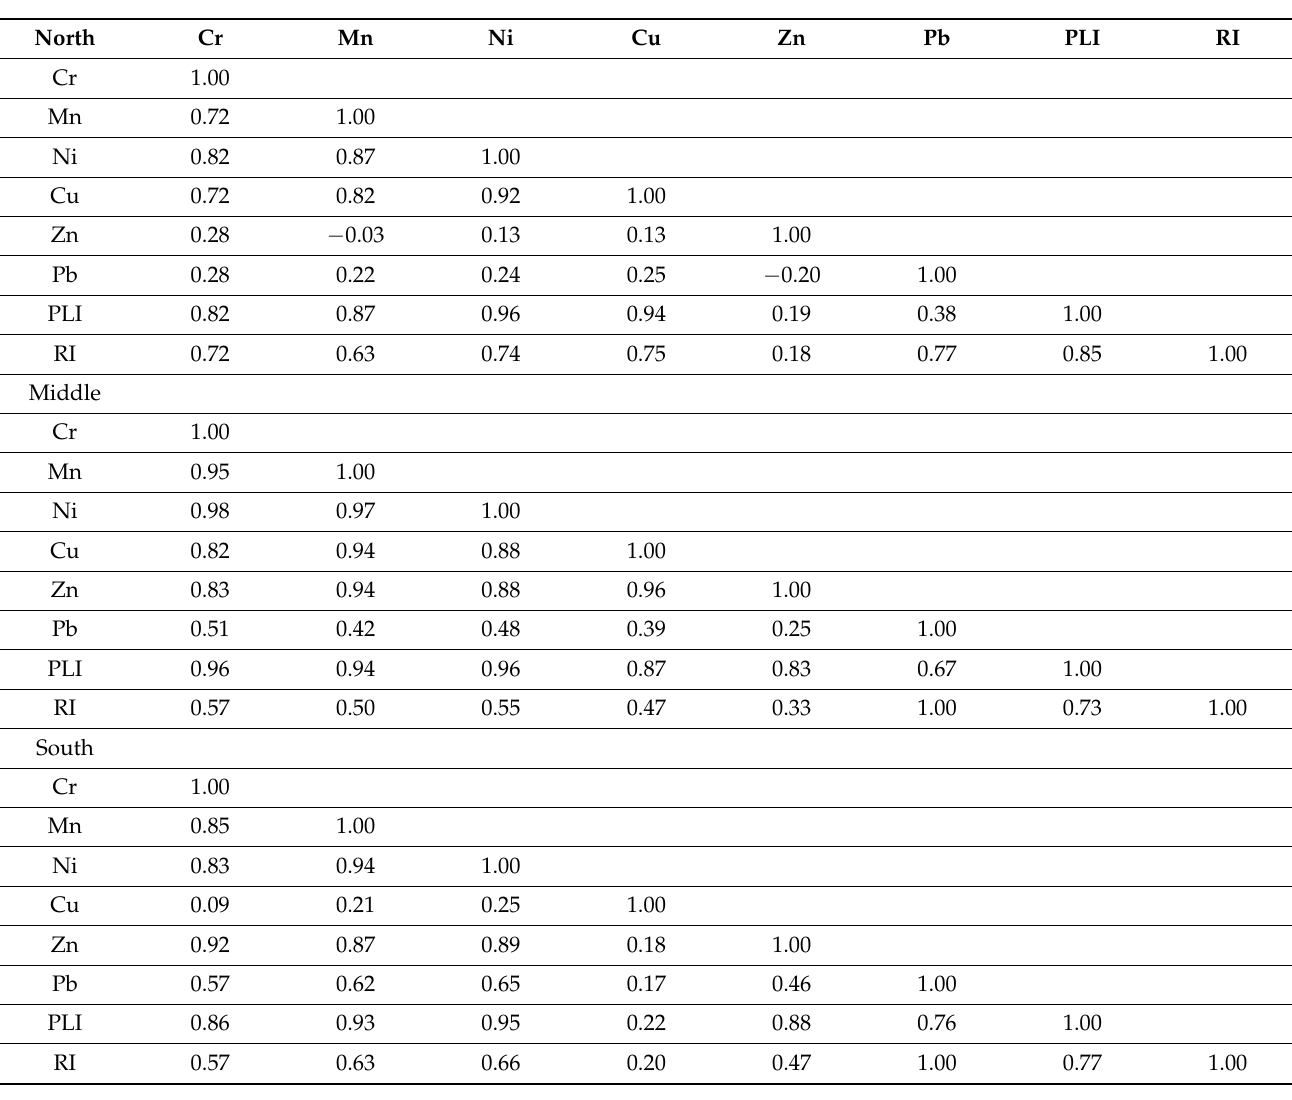
Table 2. Correlation coefficients for heavy metals concentrations in marine sediment samples from each location near Jeddah, Pollution Load Index (PLI) and the Potential Toxicity Response Index